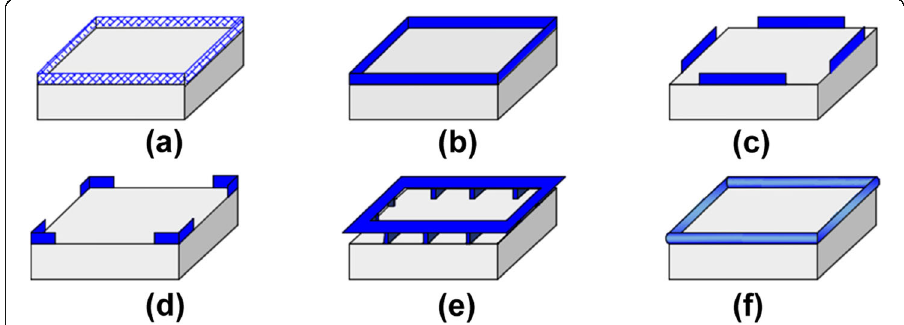
Fig. 2 Various aerodynamic mitigation features for reducing wind loads on the roofs of low-rise buildings: ( a ) porous parapet, ( b ) solid parapet, ( c ) discontinuous parapet, ( d ) partial parapet, ( e ) parametric spoiler, and ( f ) aerodynamic